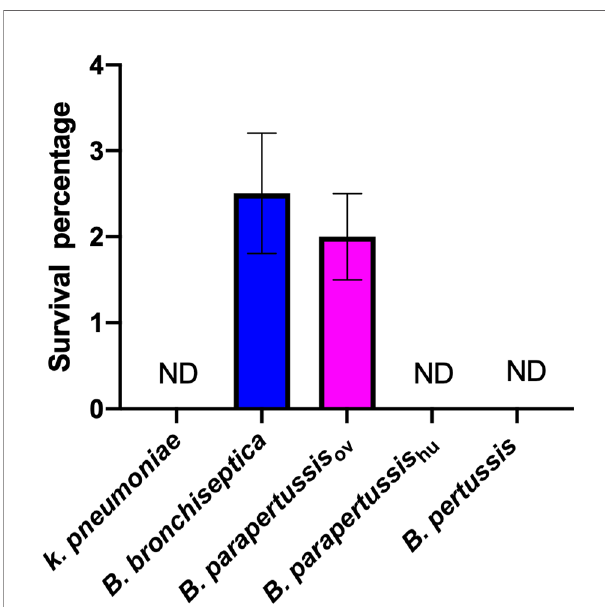
FIGURE 1 | Human-restricted classical Bordetella species, B. pertussis and B. parapertussis human strain, fail to survive inside vegetative amoebae. Intracellular survival of three “ classical ” Bordetella species inside single cell amoeba was assessed in gentamicin protection assays. There were 3 replicates in each group. Error bars show the standard error of the mean. ND, none detected.